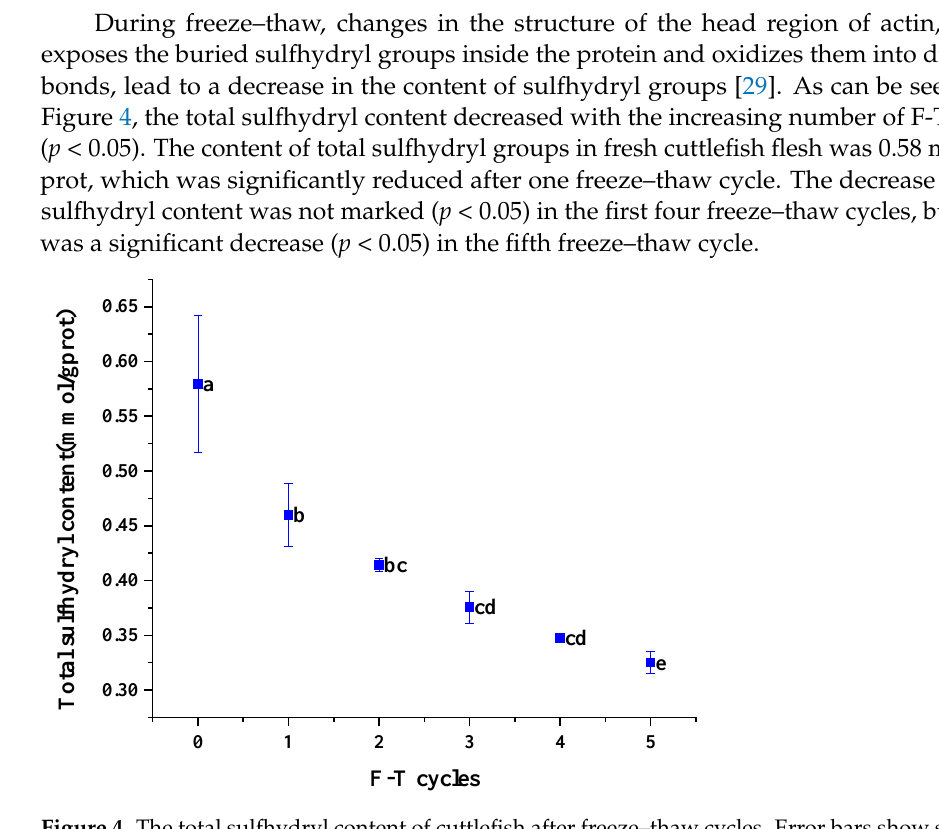
Figure 4. The total sulfhydryl content of cuttlefish after freeze–thaw cycles. Error bars show standard deviation. The letters “a–e” indicate significant differences ( p <